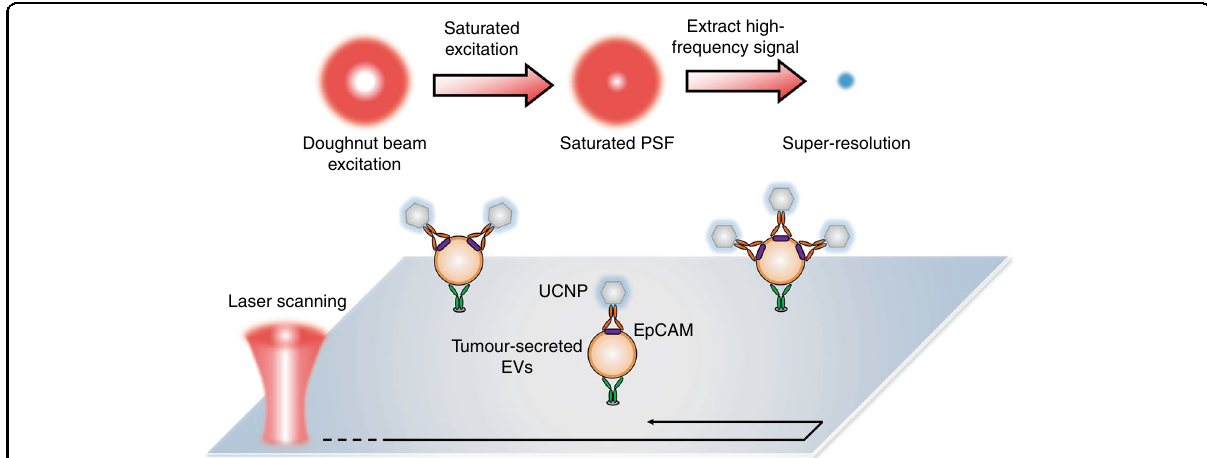
Fig. 1 Upconversion nanoscopy for EVs surface molecules quanti fi cation. By using saturated excitation of doughnut-shaped beam, both the high-resolution images and quanti fi able luminescence intensity can reveal the number of labelled upconversion nanoparticles on each